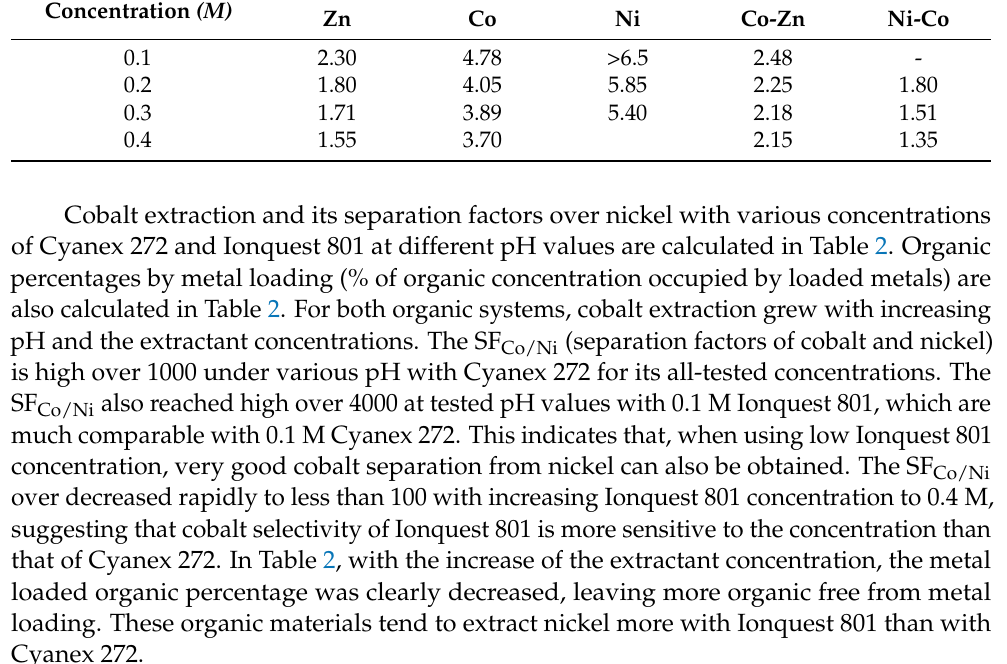
Table 2. Cobalt extraction, its separation factor over nickel (SF Co/Ni ), and organic loading percentages with Cyanex 272 and Ionquest 801. Co Extraction (%) Cyanex 272 Concentration (M)